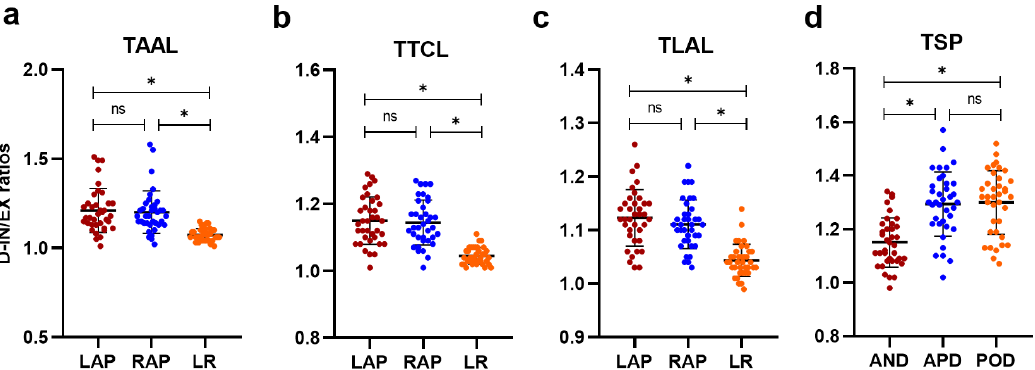
Figure 4. The scatter plots present the difference of ratios between different directions on each plane during deep breathing ( a – d ). D-IN/EX ratios, the ratio between end-inspiration and end-expiration in deep breathing; TAAL, the aortic arch level; TTCL, the tracheal carina level; TLAL, the liver apex level; TSP, the right sagittal plane; LAP, the anterior – posterior distance of left thorax; RAP, the anterior – posterior distance of right thorax; LR, the left to right distance of thorax; AND, the distance between the lung apex and anterior diaphragm on the sagittal plane; APD, the distance between the lung apex and diaphragm apex on sagittal plane; POD, the distance between the lung apex and posterior diaphragm on sagittal plane. ns indicated p > 0.05, * indicated p < 0.05.